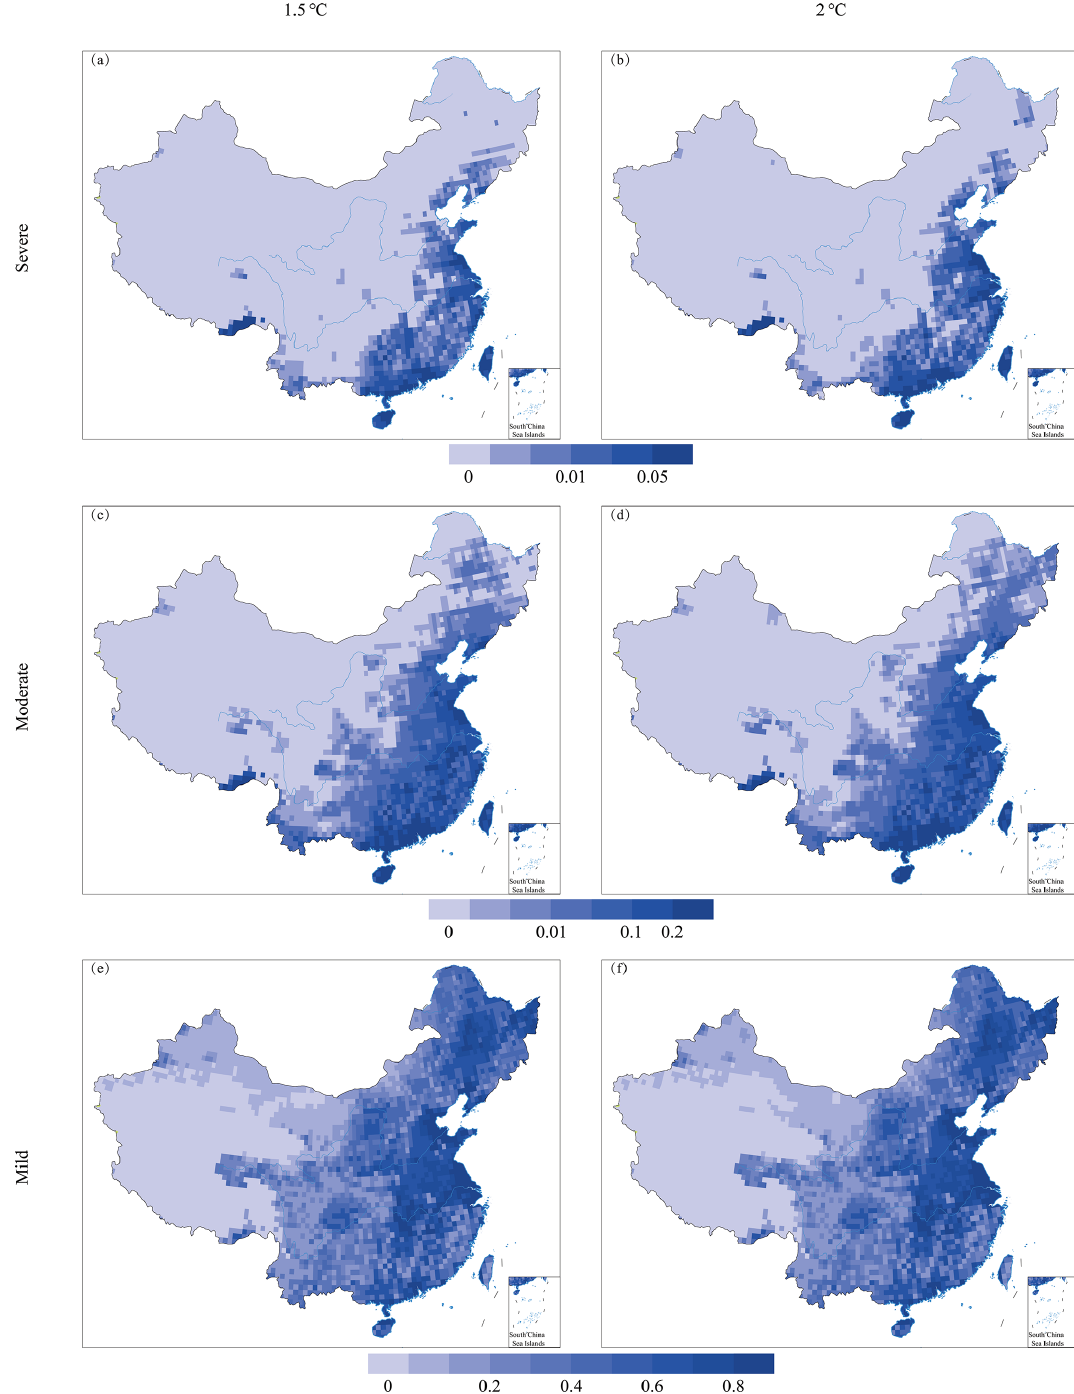
Figure 2. Spatial patterns of the probability of severe (a–b) , moderate (c–d) and mild (e–f) floods for 1.5 ◦ C (a, c, e) and 2 ◦ C (b, d, f) of global warming under the RCP8.5